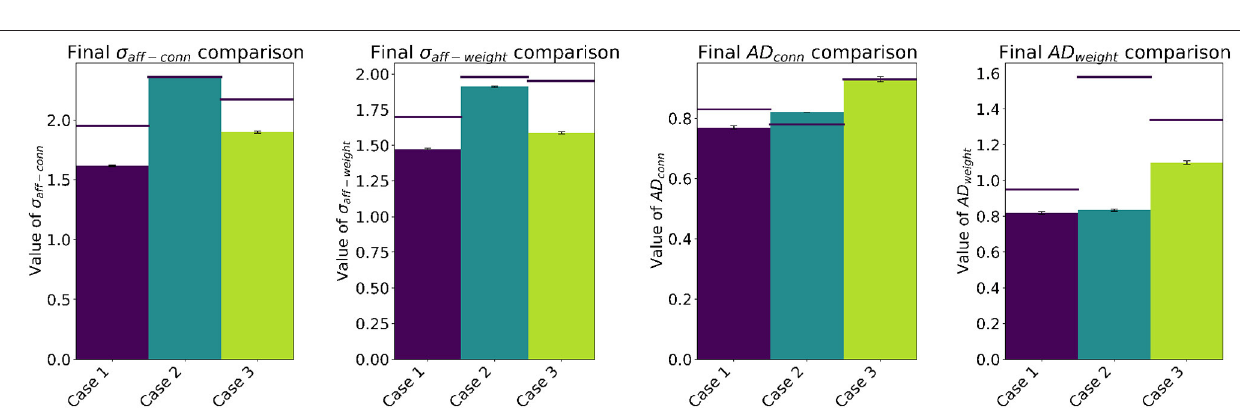
Frontiers in Neuroscience |